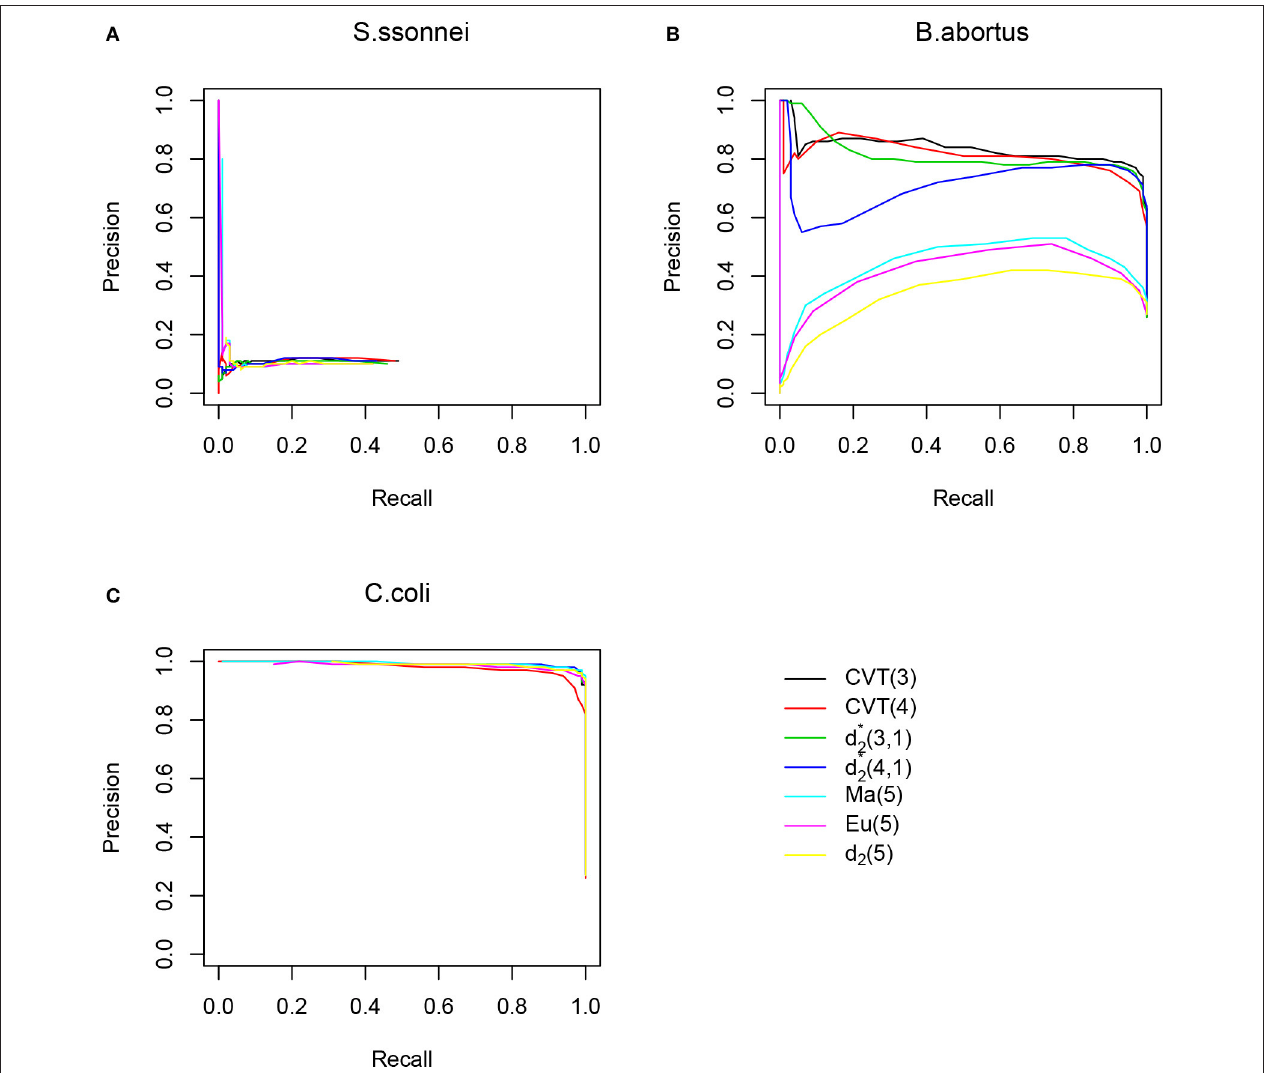
FIGURE 2 | The Precision-Recall Curves (PRC) of different HGT detection methods along artificial genomes using E. coli as host genome. (A) PRC when using S.sonnei as donor genome, no methods performs well. (B) PRC when using B. abortus as donor genome, CVT (3), CVT (4), d ∗ 2 (3,1) and d ∗ 2 (4,1) outperform other methods. (C) PRC when using C.coli as donor genome, all methods perform reasonably